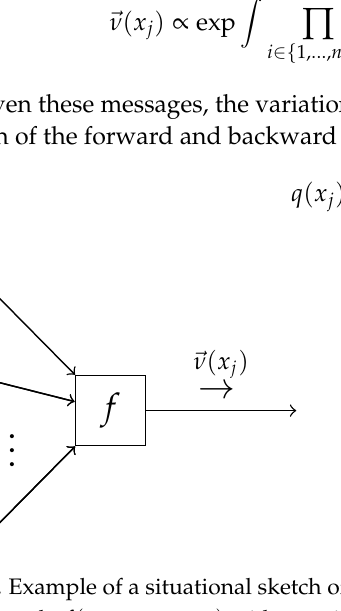
) j \ ) with marginals q ( x ) . , x , . . . , x n 2 1 j \